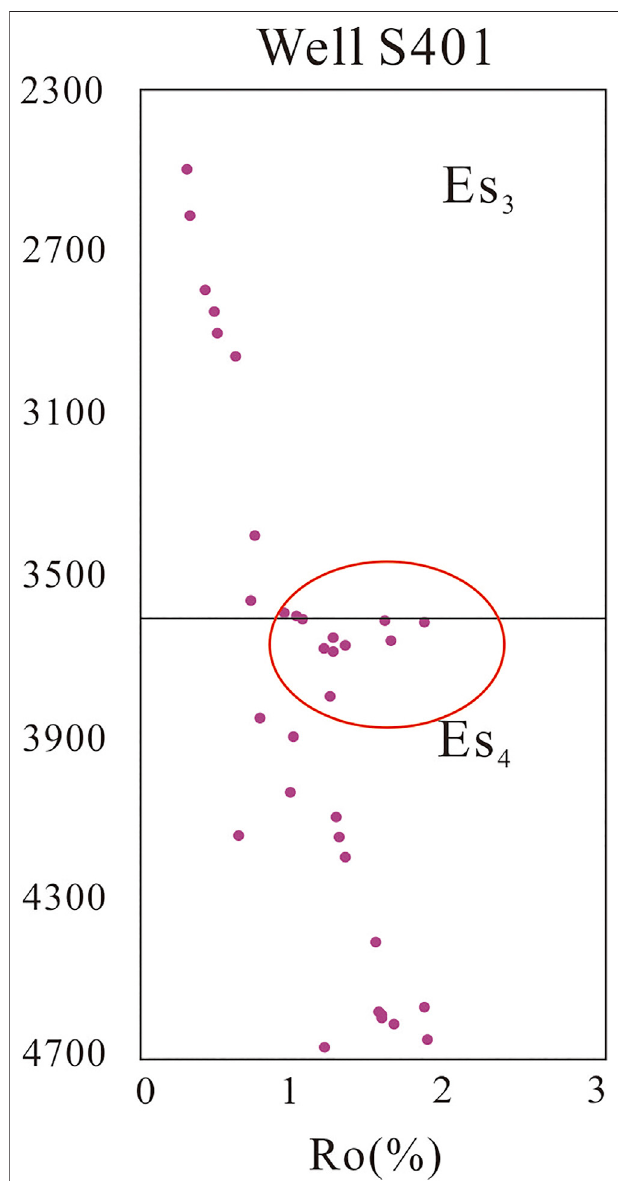
FIGURE 10 | Relationship between Ro and depth in well